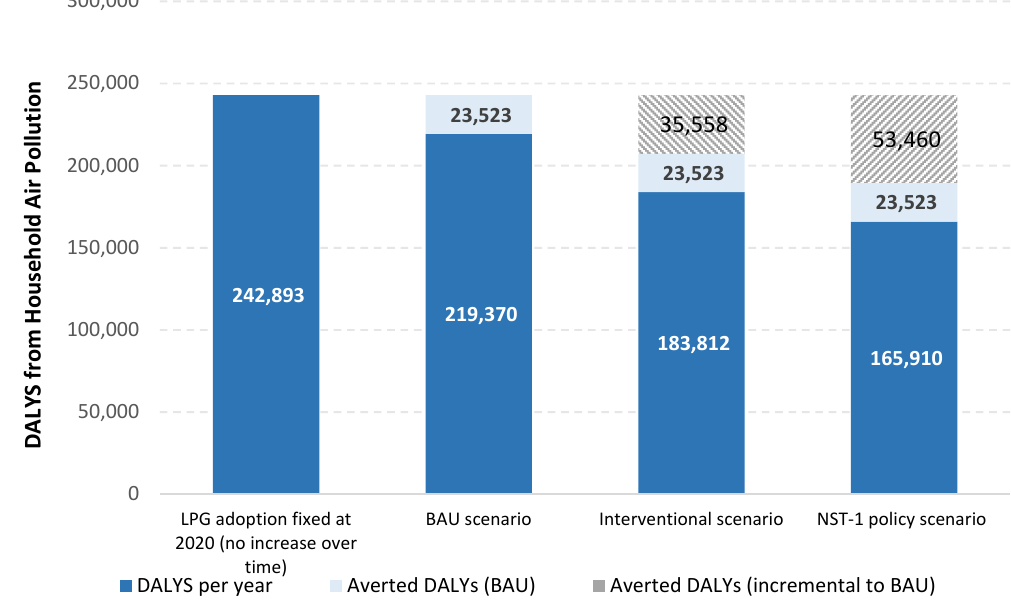
Figure 5. Results on projected health impacts in 2030 according to each LPG adoption scenario. Note: This is an approxima-